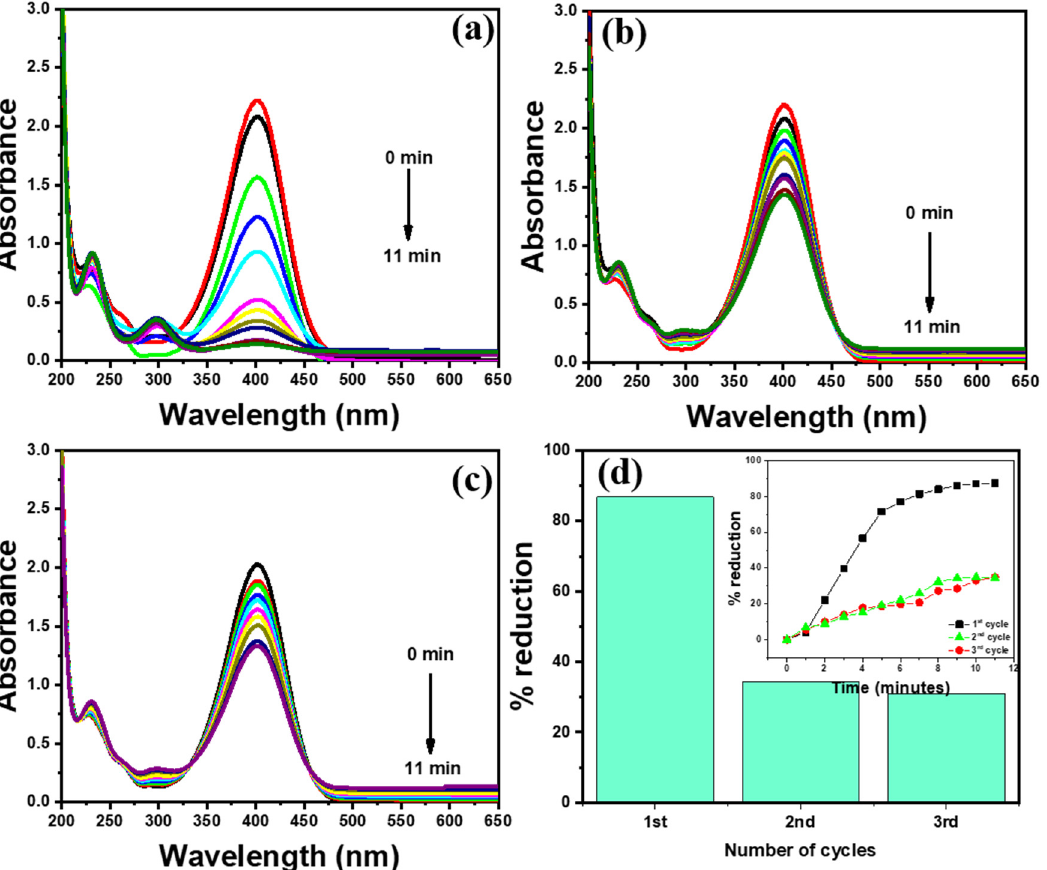
Figure 7. Recyclability of the CS-AC catalyst against 4NP reduction. The absorbance spectrum of 4NP reduction for the 1st cycle ( a ), 2nd cycle ( b ) and 3rd cycle ( c ), and the % reduction of 4NP against the number of cycles ( d ). The bar graph shows the % reduction of 4NP as a function of time in Figure 7d. Experimental conditions: 4NP (2.5 mL of 0.13 mM); NaBH 4 (0.5 mL of 0.5 mM); 20 mg of CS-AC catalyst.